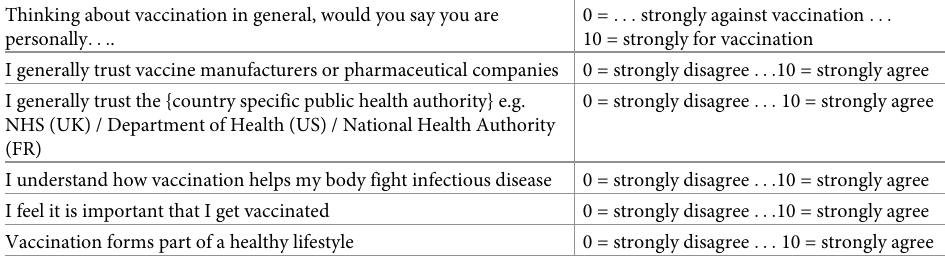
Table 1. Vaccine Trust Indicator